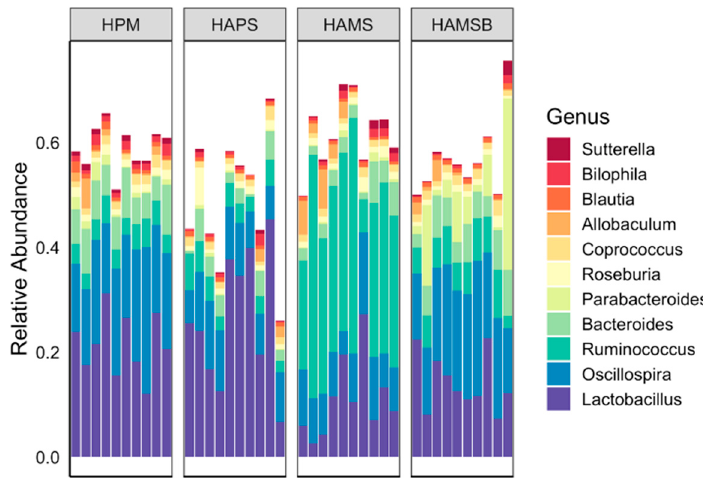
Figure 2. Relative abundance of bacterial genera in rat cecal contents. Each bar represents the bacterial composition in individual cecal samples. Genera constituting ≥ 0.01 of total bacteria present are shown.